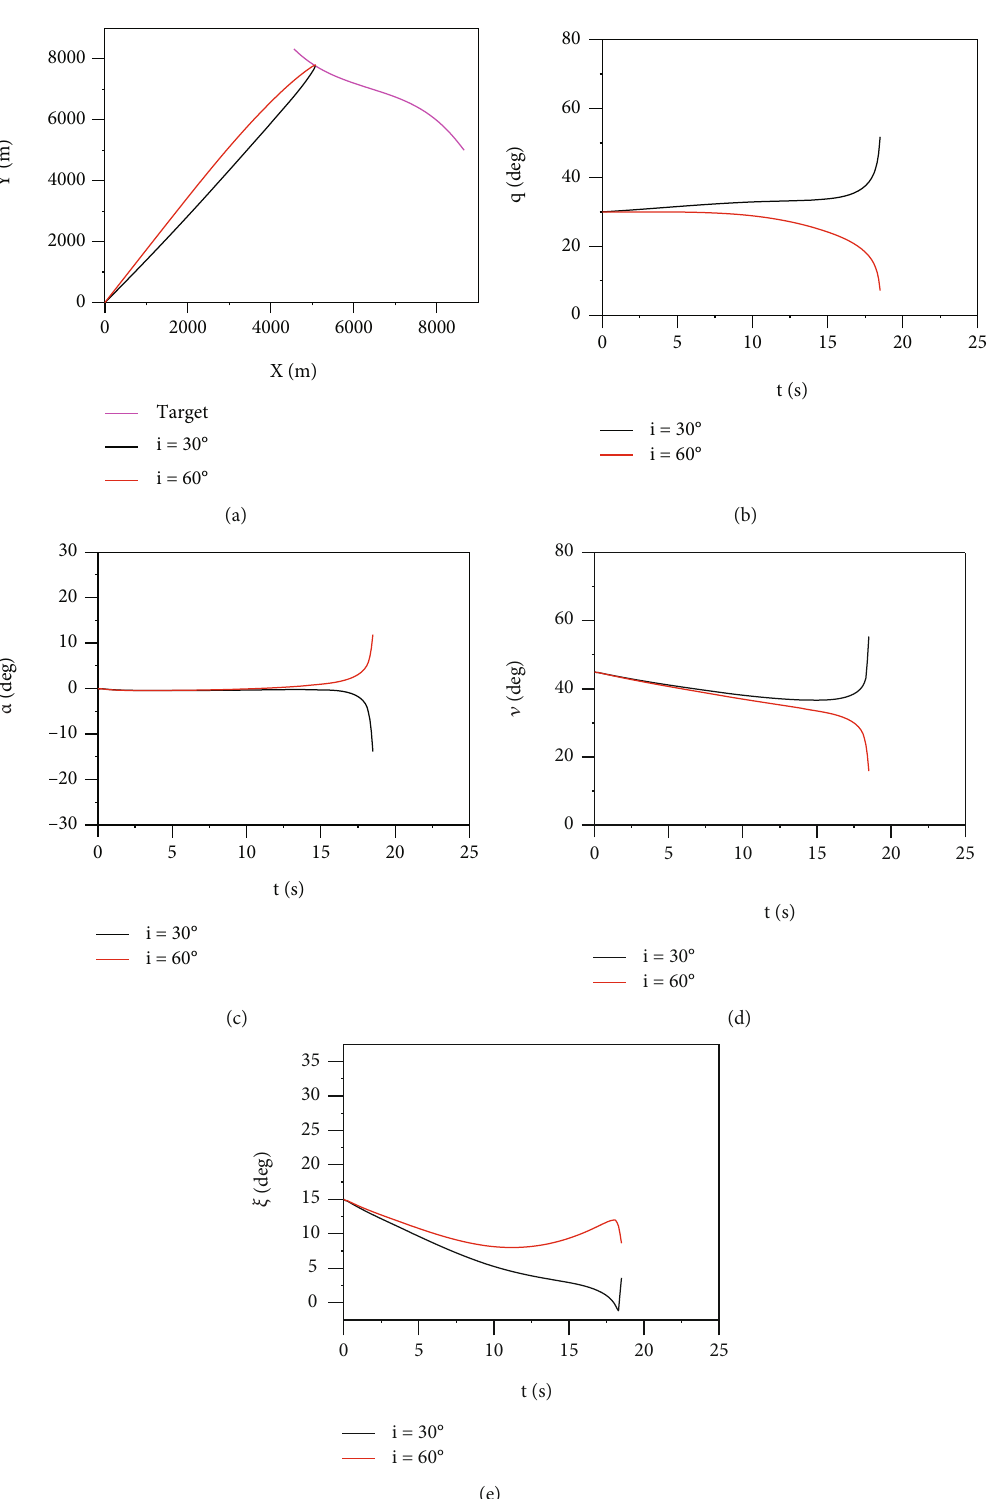
Figure 7: Simulation results under Case 3: (a) intercept trajectory, (b) the LOS angle, (c) the attack angle, (d) the pitch angle, and (e) the fi eld-of-view